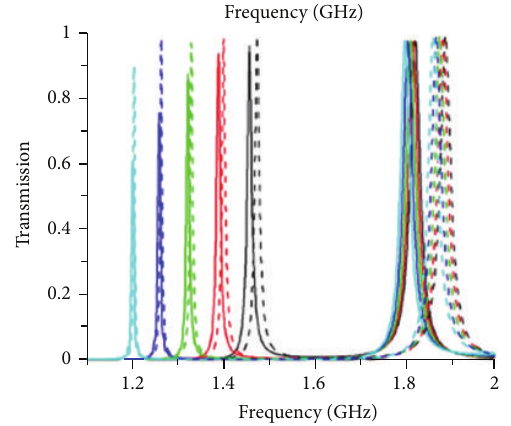
Figure 20: Transmission coefficient for the ultranarrow channel sensor with 𝐿 = 127 mm, 𝑏 = 2𝑎 = 101.6 mm, 𝜀 = 2𝜀 0 , 𝜀 = 𝑎/64 , and 𝐿 = 𝐿/5 𝑎 ch cav